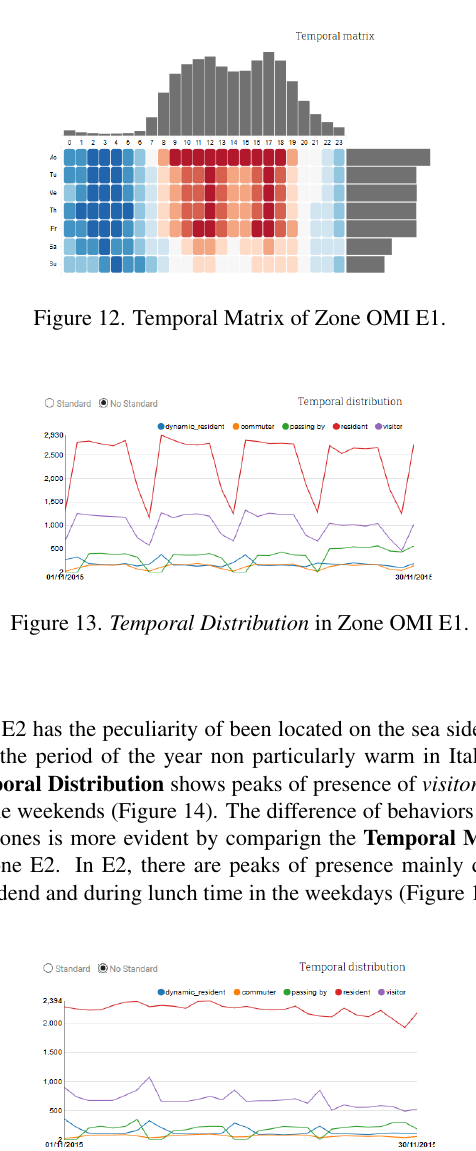
Figure 14. Temporal Distribution in Zone OMI E2.